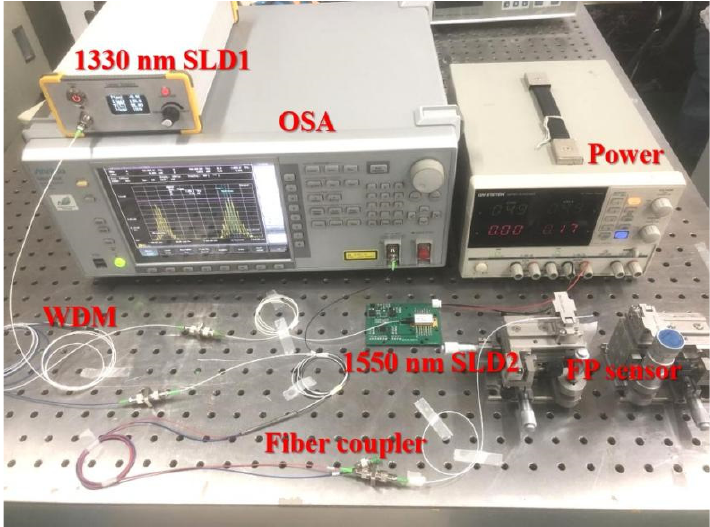
Figure 8. Experimental setup of the fiber-optic F–P sensor demodulation system.